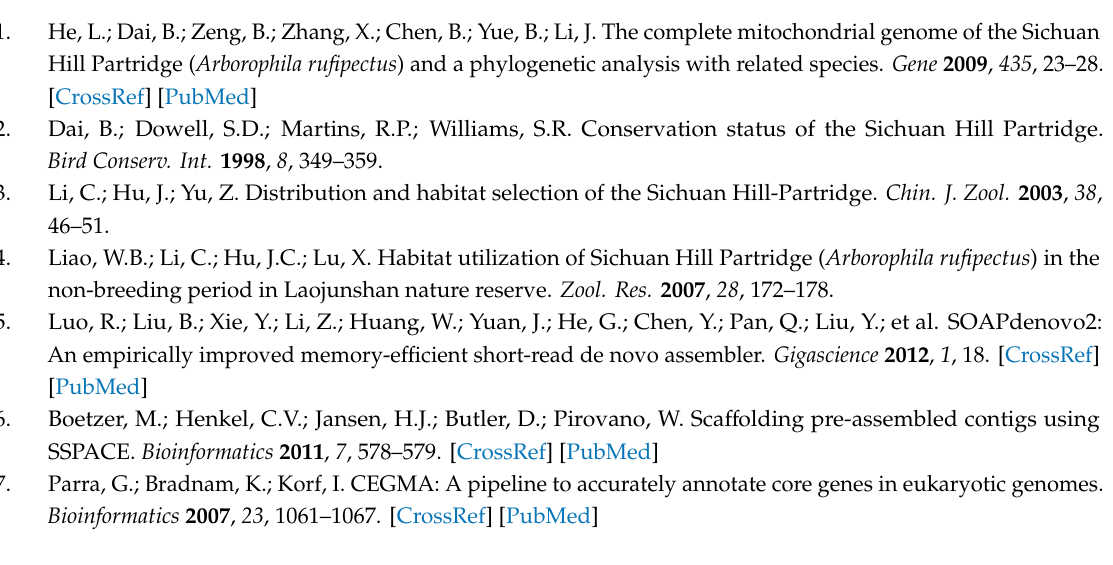
Table S1: Statistics of the genome completeness of the Sichuan partridge based on 248 CEGs, Table S2: Statistics of the genome completeness of Sichuan partridge based on BUSCO benchmark, Table S3: Functional annotation statistics of the Sichuan partridge genome, Table S4: The number and frequency of the SSRs in the Sichuan Partridge genome, Table S5: The most abundant motif categories found in the Sichuan partridge genome, Table S6: GO enrichment of the PSGs in the Sichuan partridge, Figure S1: The alignment of Sichuan partridge sca ff olds to the chicken reference